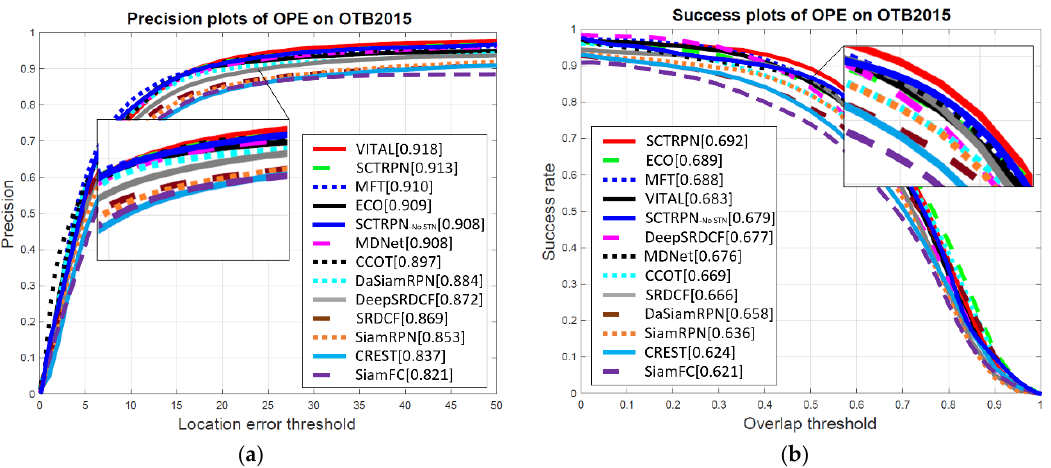
Figure 7. Precision and success plots show a comparison of our SCTRPN tracker with state-of-the-art trackers on the OTB2015 dataset. ( a ) Precision plots of OPE on OTB2015; ( b ) Success plots of OPE on OTB2015.